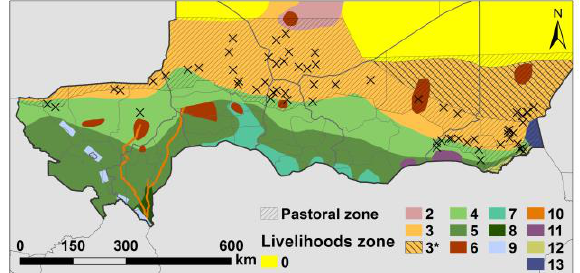
Figure 2. Livelihoods zones (FEWS NET, 2011), pastoral zone